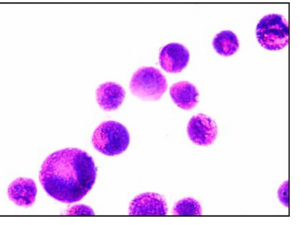
Figure 5. Micrograph of untreated Hep-2 cells (control cells) at the power of 1000X oil. Some of these morphological criteria of alterations, including apoptosis and necrosis, were more obvious and more common in cells treated with P-Lip.